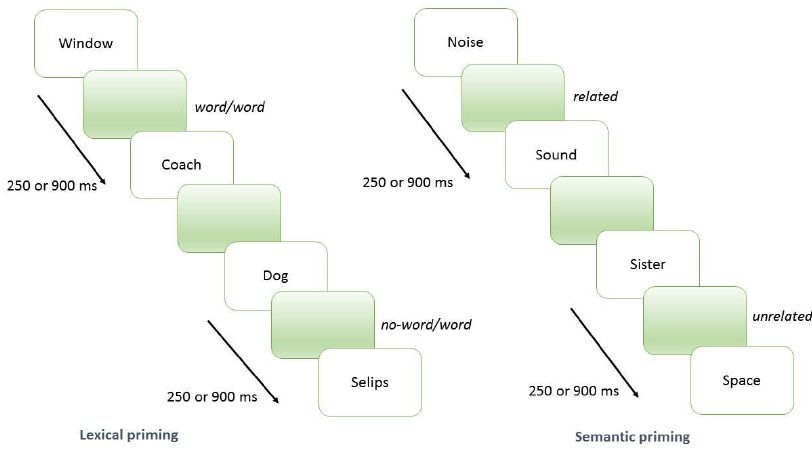
Figure 1. Assessment of the lexical and semantic priming tasks.